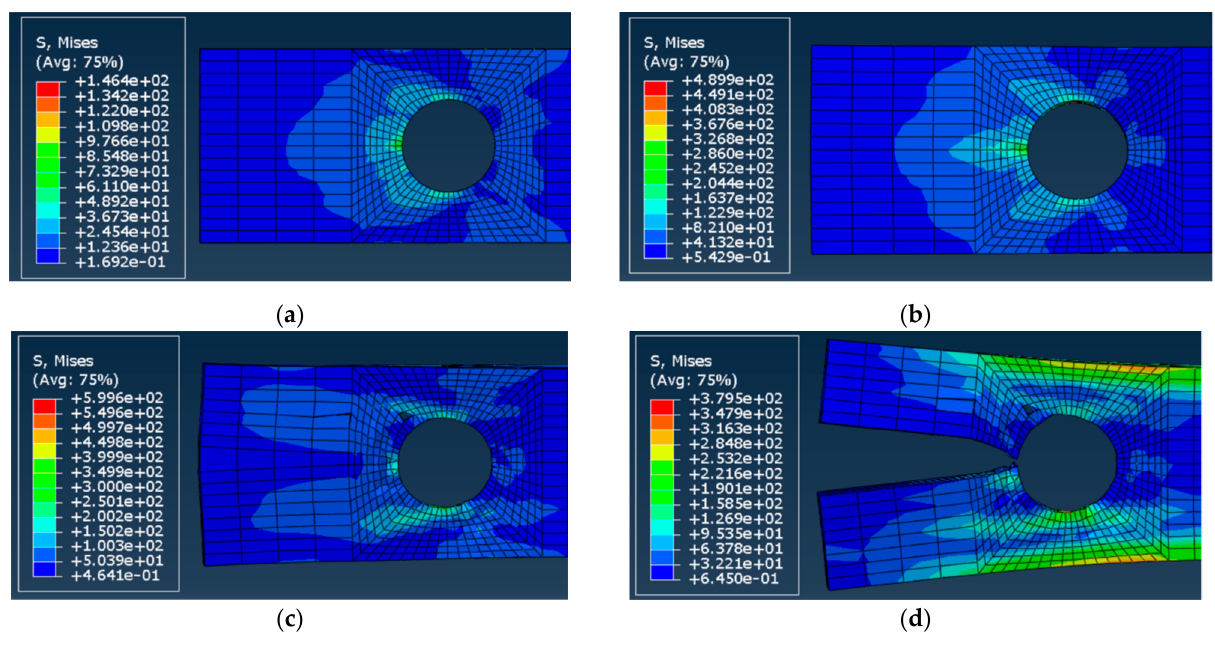
Figure 11. Numerically predicted deformation behavior and stress distribution in the A-12 joint (refer to Figure 10b for the deformation stages): ( a ) Displacement u = 0.259 mm, load P = 1.500 kN; ( b ) u = 1.040 mm, P = 6.500 kN; ( c ) u = 1.350 mm, P = 7.630 kN; ( d ) u = 2.440 mm, P = 0.798 kN.